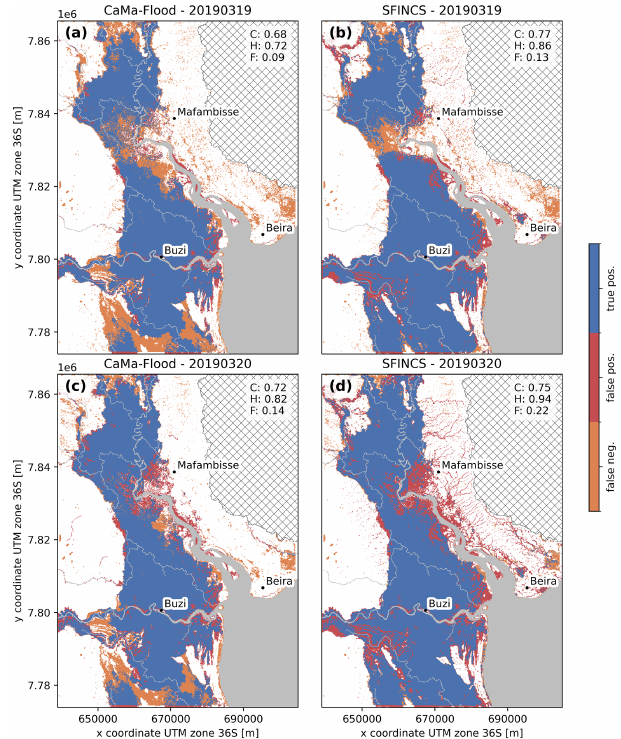
Figure A2. Simulated maximum flood depths from CaMa-Flood (a, c) and SFINCS (b, d) for Tropical Cyclone Idai on 19 March (a, b) and 20 March (c, d) . The grey areas indicate permanent water, and the hatched areas are